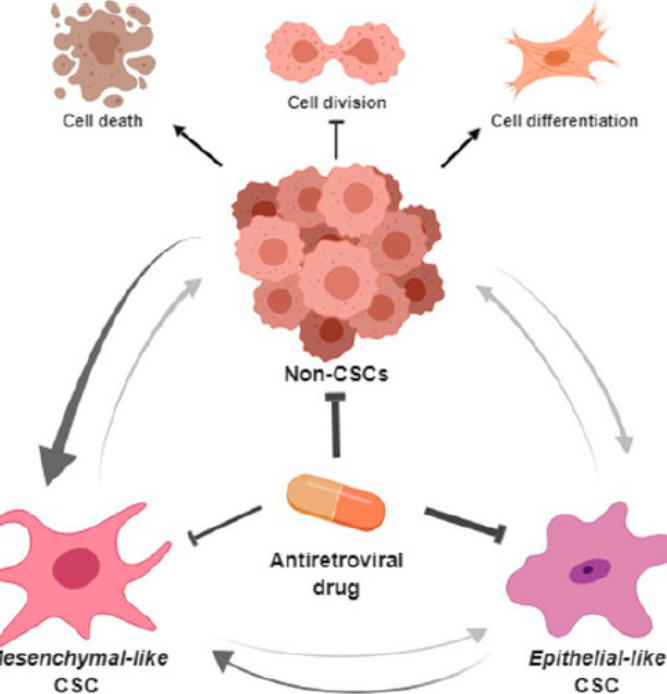
Figure 6. Putative roles of Efavirenz in breast cancer treatment. Efavirenz may antagonise the progress of breast cancers by targeting both CSCs and non-CSCs. It can promote cell differentiation in undifferentiated cancer cells, can suppress cancer cell division and can induce cancer cell death. Although efavirenz has the ability to reduce the epithelial-like CSCs, mesenchymal-like CSCs are more resistant to antiretroviral drugs compared with other types of breast cancer cells. Furthermore, cancer cells can potentially switch their status between CSCs and non-CSCs because of their plasticity. Breast cancer cells tend to have a preference for maintaining and/or increasing their mesenchymal-like CSC status under antiretroviral drug treatment condition. (Schematic diagrams were created by bioRender online software).